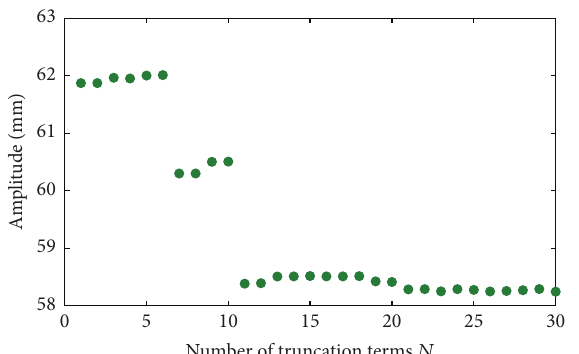
Figure 10: Effects of the number of Galerkin truncation terms on transverse displacements of the midpoint of the deck beam when there are geometric nonlinear terms.